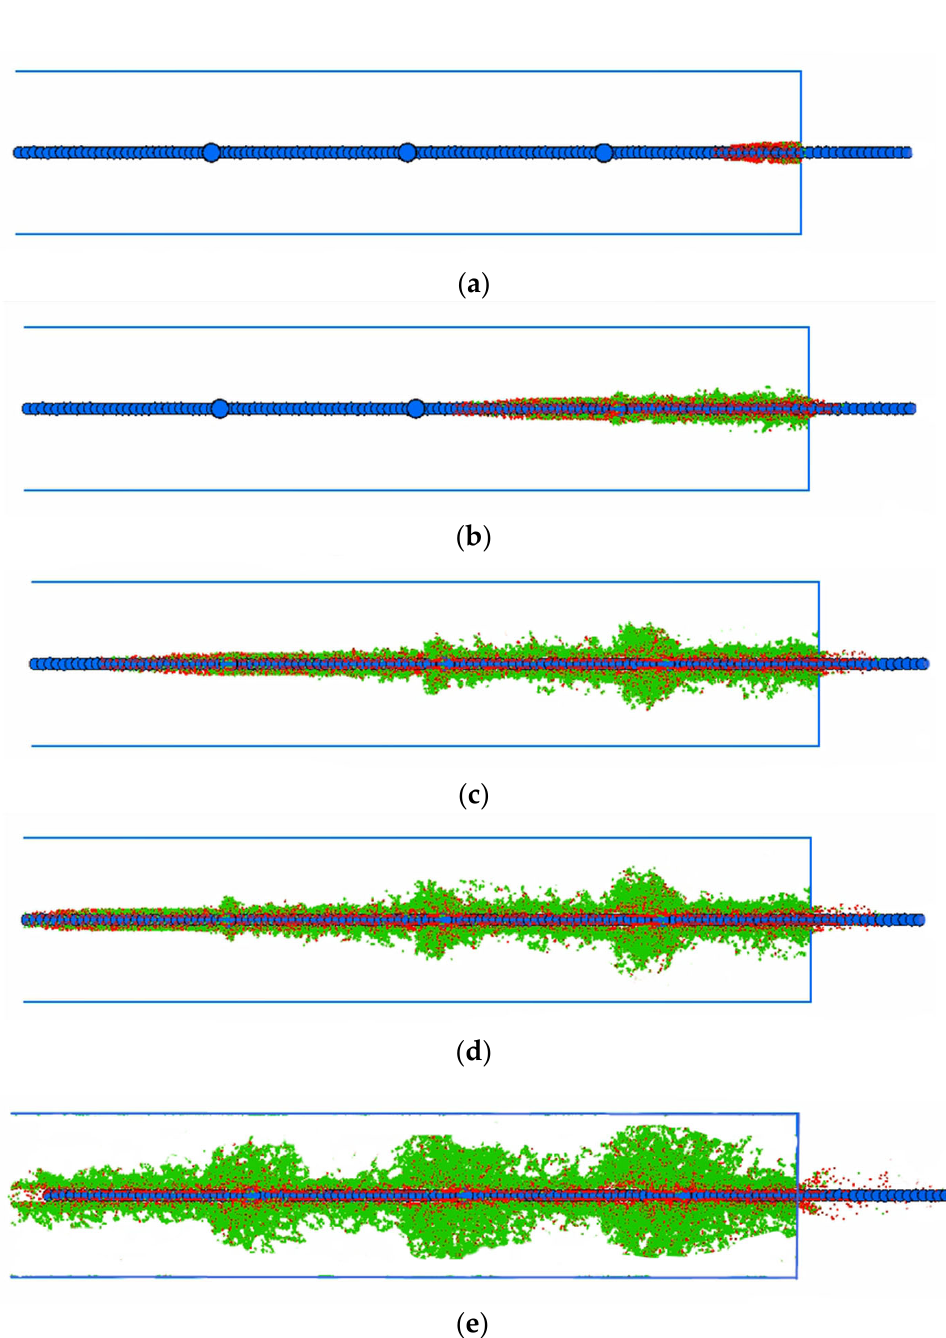
Figure 13. Failure process of the anchoring structure during PFC simulation test. ( a ) Step 250 (crack number 4000, shear crack 2500, tension crack 1500); ( b ) step 1250 (crack number 28000, shear crack 16000, tension crack 12000); ( c ) step 2400 (crack number 58000, shear crack 19000, tension crack 39000); ( d ) step 2600 (crack number 62000, shear crack 20000, tension crack 42000); ( e ) step 10000 (crack number 87000, shear crack 21000, tension crack 66000).